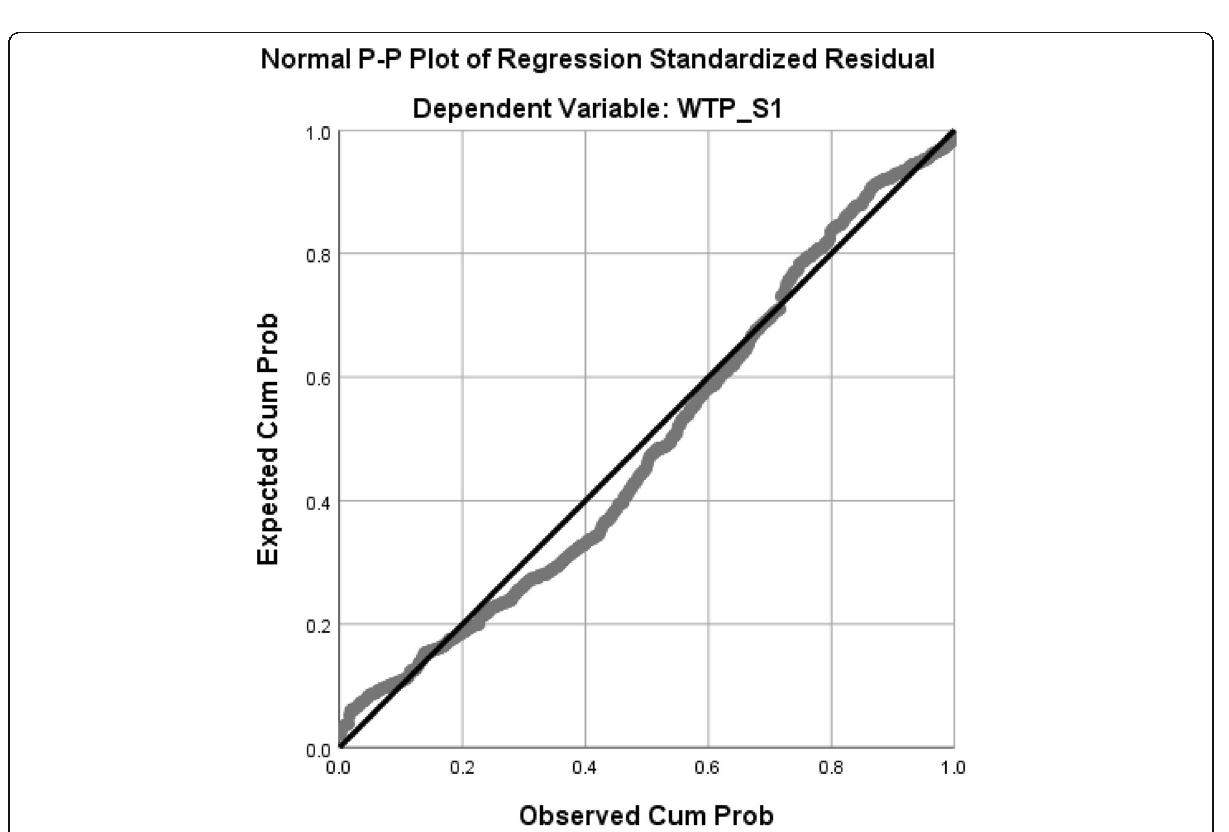
Fig. 8 Normal P-P Plot of the residuals of regression of Model A (explanatory variables against WTP for